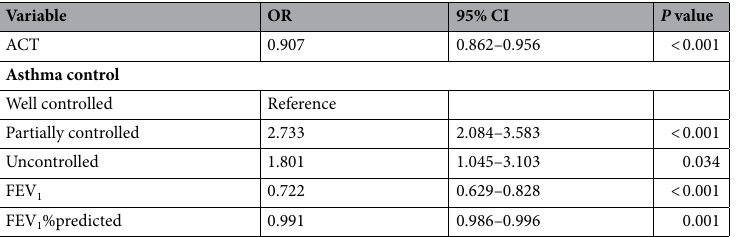
Table 2. Multivariate logistic regression analysis of factors associated with smoking cessation based on clinical parameters. Values were expressed as odds ratio (OR) and 95% confidence interval (CI). Factors associated with smoking cessation were determined by multivariate logistic regression analysis. Multivariate analysis was adjusted for ACT, FEV 1 , FEV 1 /FVC, age, sex, marriage, BMI, Pack-years and Years of smoking. P < 0.05 was considered statistically significant. ACT asthma control test, 95%CI 95% confidence interval, FEV 1 forced expiratory volume in 1 s, FVC forced vital capacity, OR odds ratio.